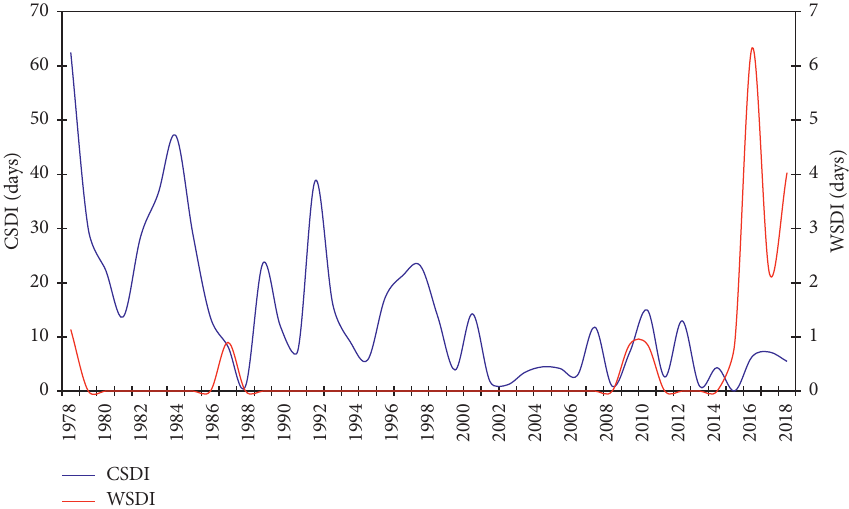
Figure 15: The country-averaged WSDI and CSDI indices over Saudi Arabia for the period